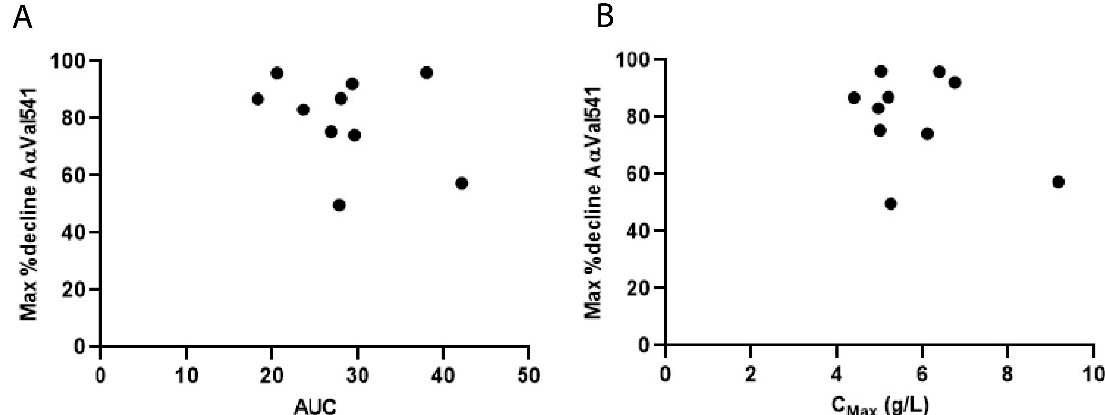
Figure 5. Summary of the course of the AAT and A α Val541 levels after one monthly dose of 240 mg/kg AAT in 10 AATD patients. Left y axis plots the AAT levels with both the predicted AAT levels by applying two-compartment pharmacokinetic model (black line), and the measured (blue dots) AAT levels at different time points over a month; the right y axis plots the A α Val541 levels (red dots) expressed as percentage of baseline (A α Val541 before the infusion) measured on the different time points. One AATD patient received another AAT infusion at day 28.